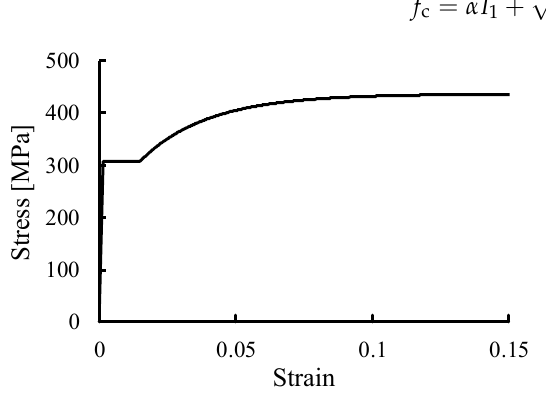
Figure 2. Steel tube stress-strain curve.